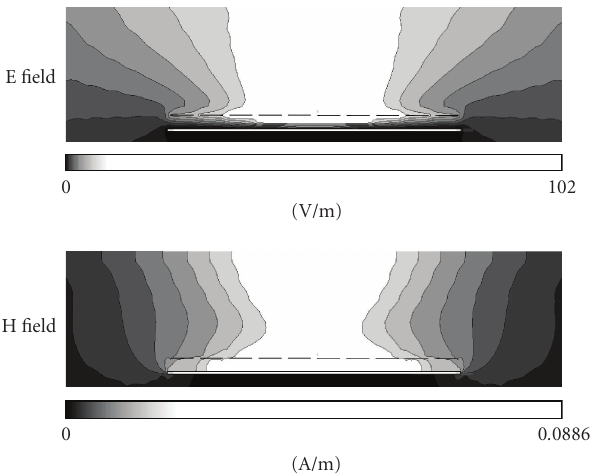
Figure 11: Field distribution in the E and H-plane at 0.9GHz.